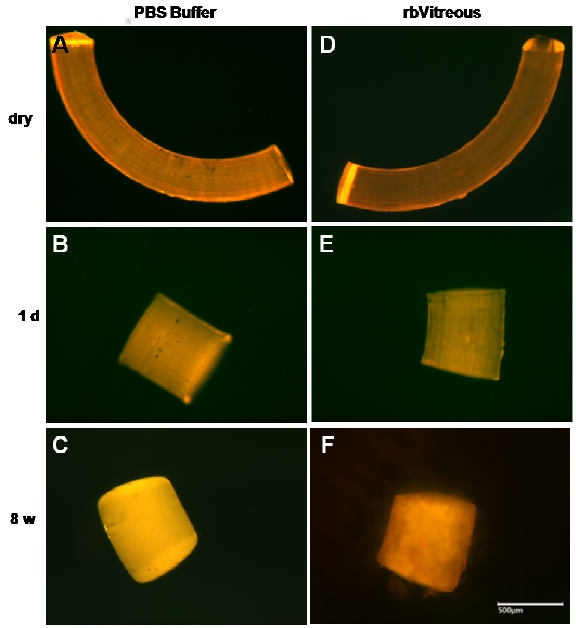
Figure 6. ( A – C ) In PBS, fibrils show rounding and smoothing of the edges after an initial shortening; ( D – F ) whereas the fibrils incubated in rabbit vitreous humor (rbVitreous) after the initial shortening, show erosive changes, as evidenced by the mottled appearance of the fibrils. Scale bar, 500 µm. Magnification, 50×.